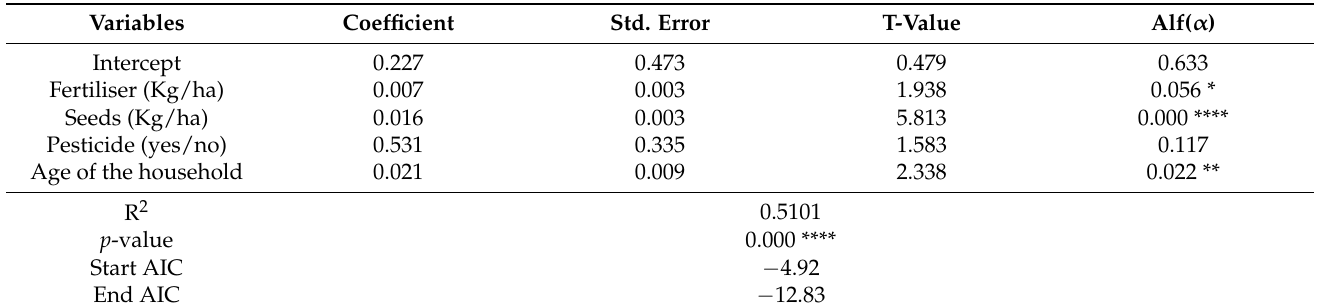
Table 6. Multiple linear regression to predict rice yield in the Ch ó kw è Irrigation Scheme.